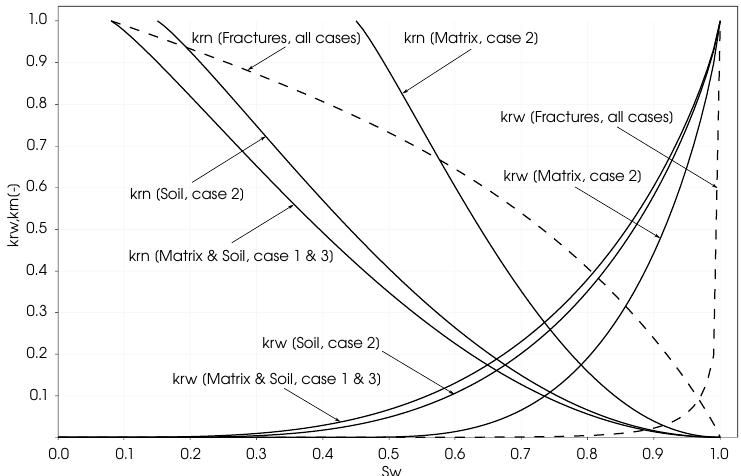
Figure 7. Relative permeability curves of matrix and fracture of model